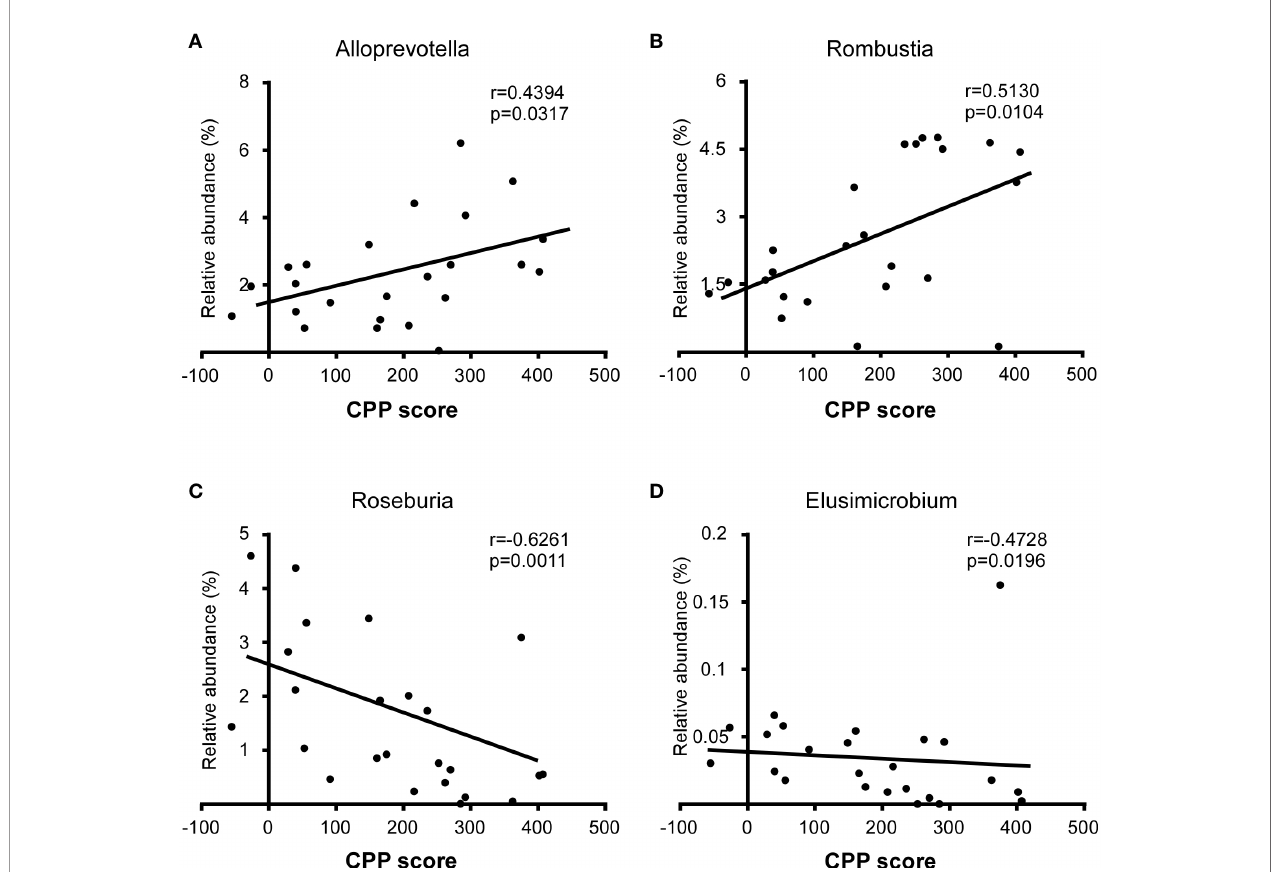
FIGURE 6 | Correlation between speci fi c taxa and the CPP scores after the morphine-induced CPP training. The relative abundance of Alloprevotella (A) and Romboutsia (B) were positively correlated with the CPP score, while the relative abundance of Roseburia (C) and Elusimicrobium (D) were negatively correlated with the CPP score. A Spearman correlation was performed for Romboutsia , Roseburia and Elusimicrobium , and a Pearson correlation was performed for Alloprevotella . The r value and p value were used to evaluate statistical signi fi cance.